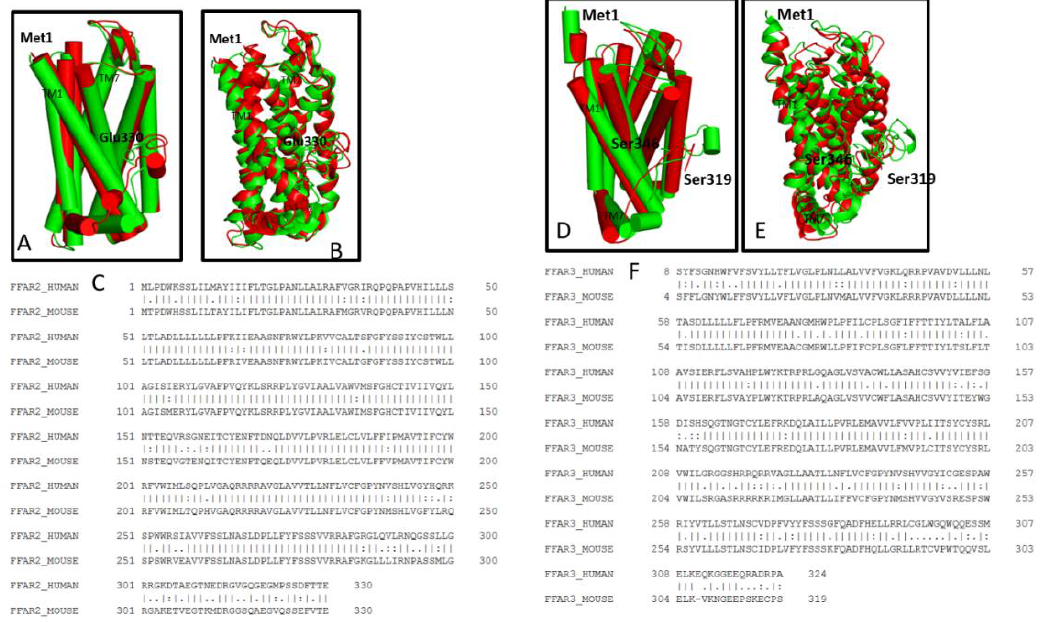
Figure 3. Superposition of mice and human FFAR2 and FFAR3 receptors ( A ‒ F ) Pipes and Plank model ( A , D ); Rainbow Ribbon Model ( B , E ); and root-mean-square deviation (RMSD) pairwise alignments of mouse and human FFAR2 ( A ‒ C ) and FFAR3 ( D ‒ F ) receptor sequence.